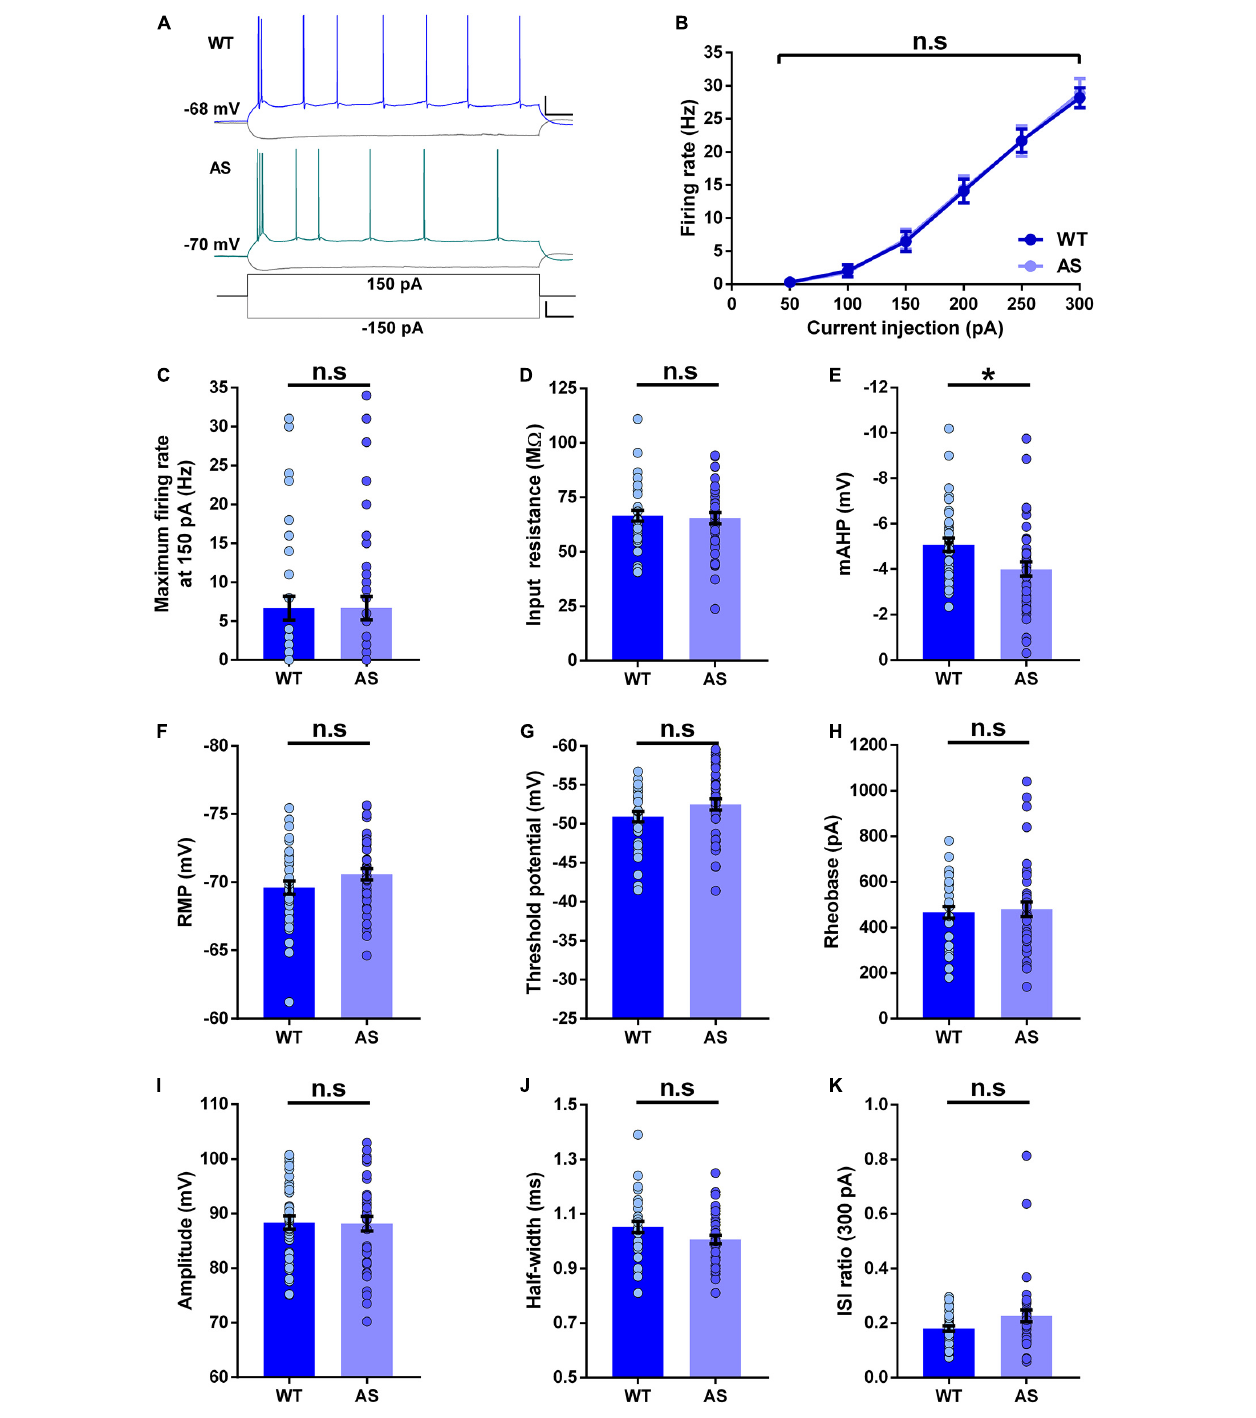
FIGURE 3 | Passive and active membrane properties of subicular WB PNs. (A) Representative current-clamp recordings of WT (blue), and AS (teal) mice following a 150 pA depolarizing and –150 pA hyperpolarizing current injection in WB neurons of the subiculum. Scale: 20 mV, 100 ms. The bottom trace shows the step current used to elicit the above responses. Scale: 100 pA, 100 ms. (B) Summary of firing response curves of all WB PNs following somatic current injection steps ranging from 50 to 300 pA grouped according to the genotype. The firing frequency is unchanged in AS mice compared to the WT controls [ F ( 1 , 73 ) = 0.007, p = 0.93 for main effect of genotype; F ( 5 , 365 ) = 0.06, p = 0.99 for interaction of genotype and current injection in two-way RM ANOVA]. (C–K) Bar graphs of passive and active membrane properties of WB neurons. (C) The average maximum firing rate remains unaltered between AS mice and their WT littermates at 150 pA current step [ t ( 73 ) = 0.008, p = 0.99]. (D) Input resistance is unchanged in AS mice in comparison to their WT counterparts [ t ( 73 ) = 0.30, p = 0.76]. (E ) The mAHP is significantly